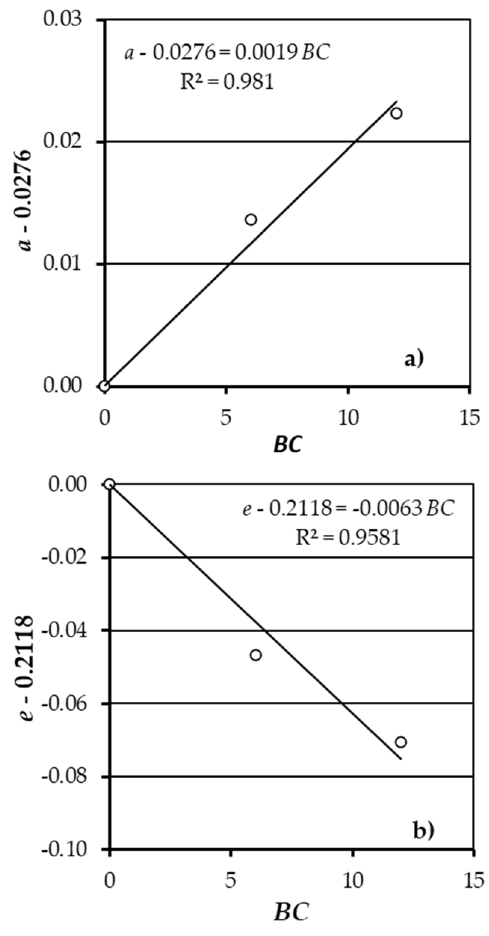
Figure 6. Relationships between the coefficients a ( a ) and e ( b ) and the biochar content BC .